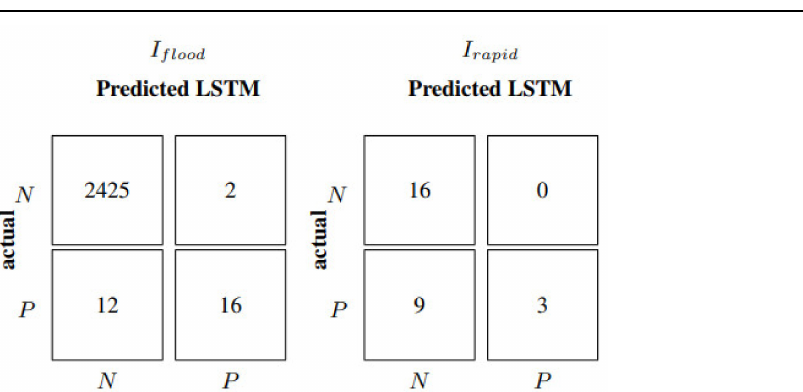
Figure 12. I flood and I rapid for the LSTM model with 60-min input update frequency. Laveggio test data, rain gauges scenario. P means a flood or a rapid event is present, N means that it is